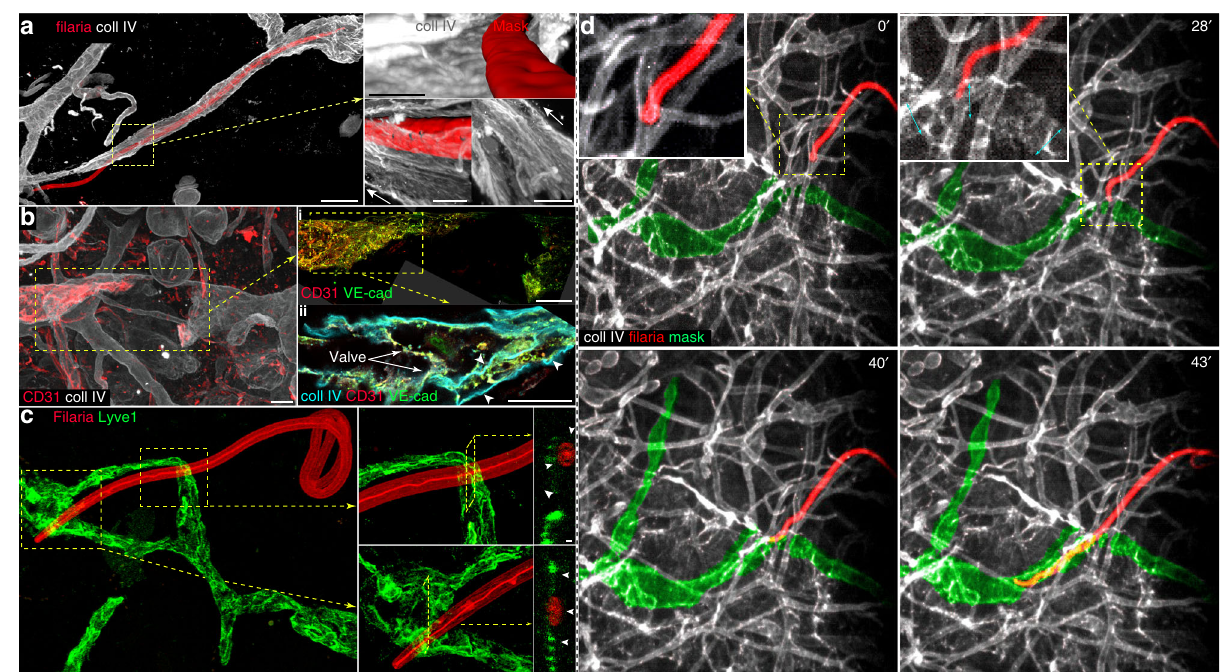
Fig. 3 Forceful fi lariae entry results in lymphatic injury. The process of a larva entering into a lymphatic vessel resulted in various levels of lymphatic damage. a The loss of the large portion of the basement membrane (BM) and reorganization of its remnants accompanied larval entry into the collagen IV (Coll IV)-stained lymphatic collector. Left: The collecting lymphatics partially invaded by fi laria. The dashed box encloses the fi laria entry site magni fi ed in the images in the right panel. Right: The damage and rearrangement of the remaining BM. Arrows point to the directional reorganization of the BM around the site of entry of the larva. b Filaria entry caused damage to both BM and the endothelial lining of the collector. The extrapolated site of entry (dashed box) of the fi laria that was pictured migrating within lymphatic in the Supplementary Movie 9. Ten hours after the fi laria crossed the collectors, the mouse was perfused- fi xed, and the entire dorsal ear dermis was restained for collagen IV, and stained for CD31 (PECAM-1) and VE-cadherin. b (panel i) The variable presence of CD31 but not VE-cadherin (VE-cad) indicates that the remodeling of the collector took place before the fi xation. Image combined from three ×100 magni fi cation fi elds. b (panel ii) A 160-nm cross-section of the area dashed in bi revealed a presence of the additional chamber (arrowheads) composed of BM and the endothelial lining, suggesting a collapse of the opposing wall of the collector. c The fi laria penetrated through two Lyve1-positive capillary lymphatics but did not enter their lumen. Arrowheads in 450 nm cross-sections point to the remnants of the cellular wall of the capillary lymphatic. d The image sequence of the fi laria entry into lymphatic collecting vessel from Supplementary Movie 7. The green delineation (mask) was manually painted over the invaded lymphatic precollector. The inset in the top row shows the head of the larva while burrowing in the blood capillary (left) and lymphatic collecting vessel (right). Coll IV-collagen IV, VE-cad-VE-cadherin. Scale bars: a Left, 200 µ m, a Right, 10 µ m, b 20 µ m, c 50 µ m (inset 5 µ